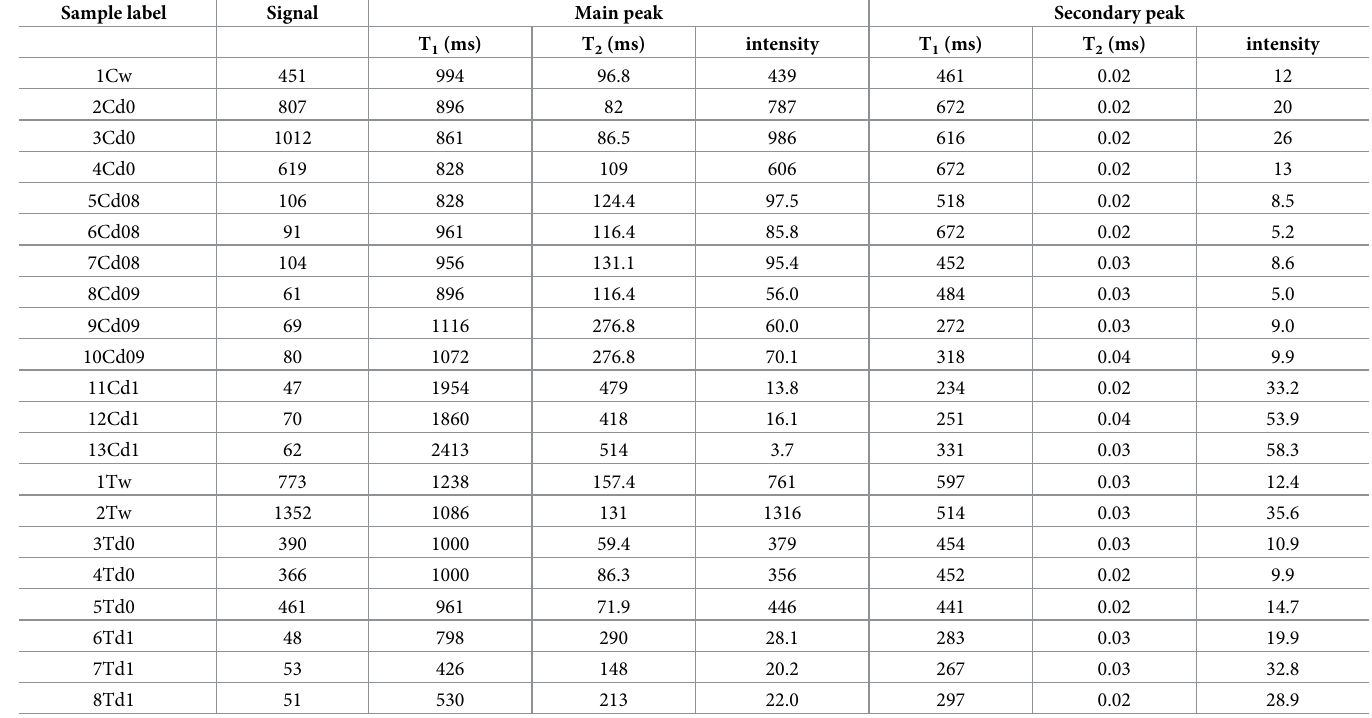
Table 3. T 1 and T 2 values of 1 H nuclei for the two peaks identified via 2D ILT in all partially deuterated samples (description see Table 1). Sample